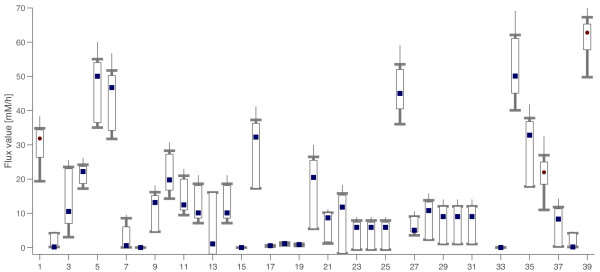
Possibilistic flux estimation for C. glutamicum lacking measurements. In this case the measured fluxes are only vGLC (1), vCO2 (39) and vBio (36). The maximum possibility flux estimation (circles and squares for measured and non-measured fluxes, respectively) and the flux intervals for conditional possibilities of 0.8 (box), 0.5 (thick line) and 0.1 (narrow line) are depicted. All fluxes in mM/h.